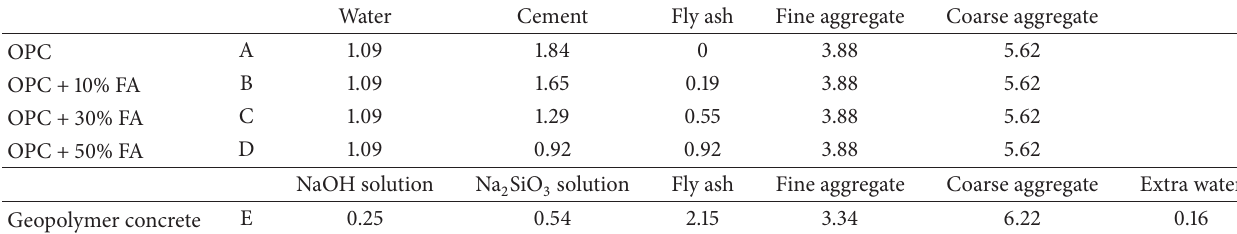
Table 1: Mixture proportion of geopolymer concrete.